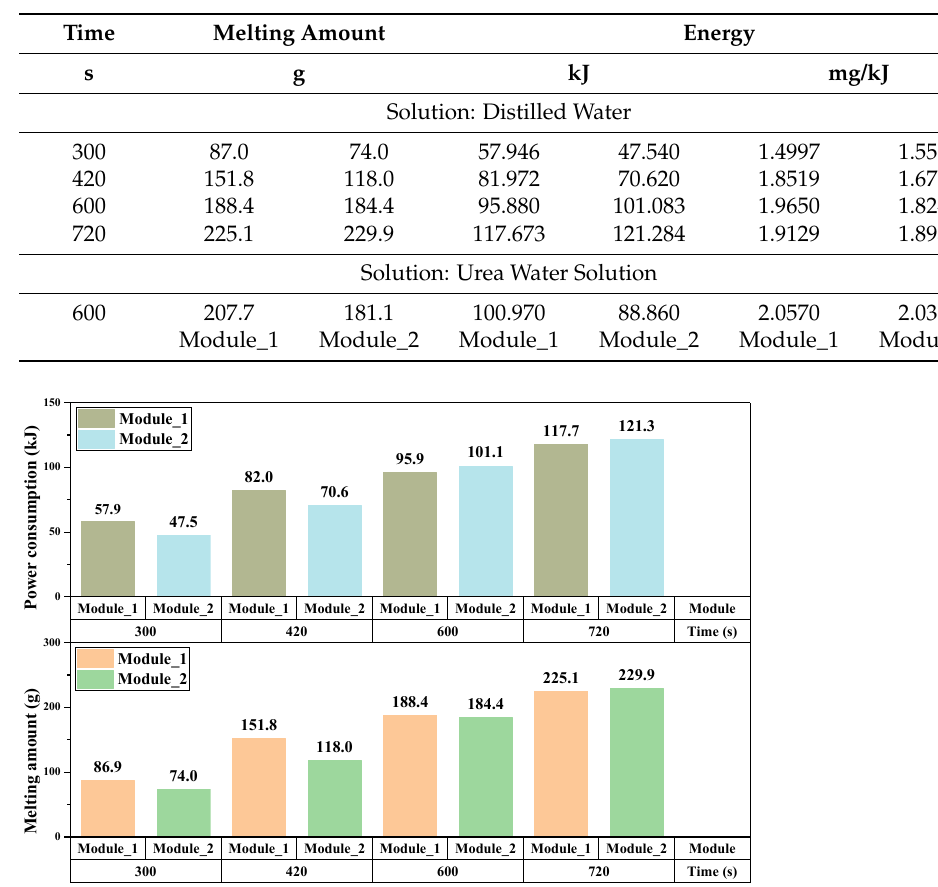
Figure 14. Mass of melt and power consumption with the passage of heating time.